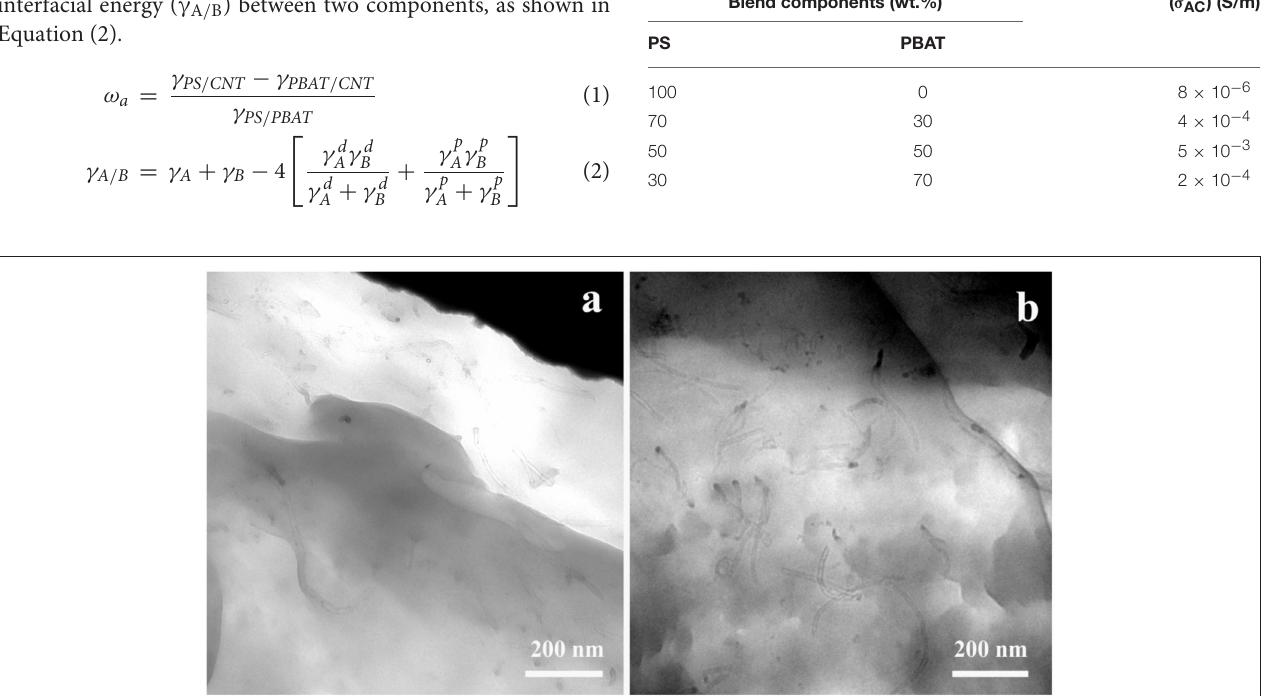
Frontiers in Materials |